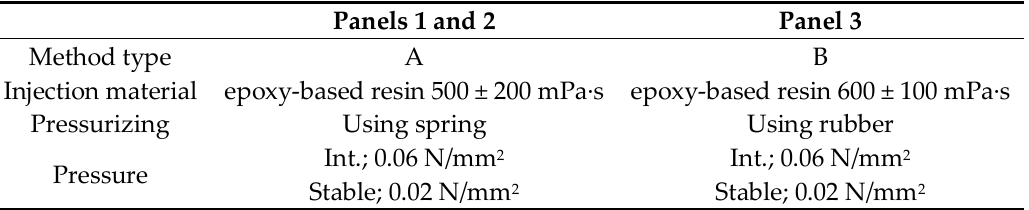
Table 2. Overview of repair.